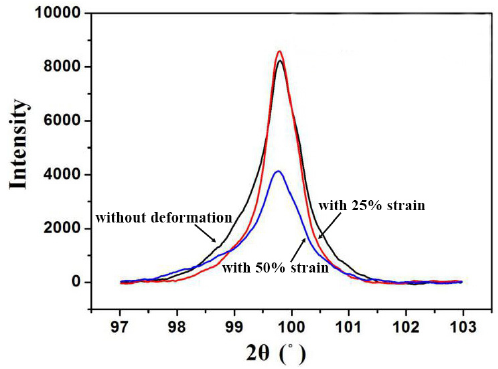
Figure 8. The (211)α diffraction peaks in different